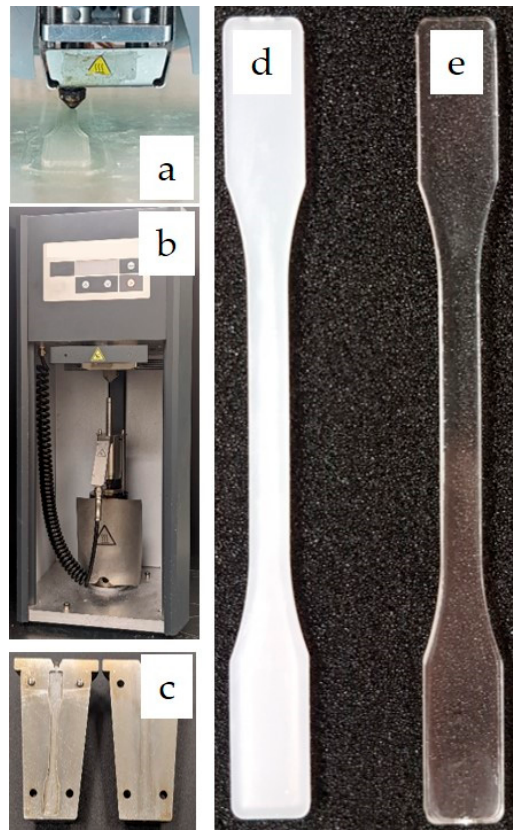
Figure 2. Image of ( a ) the FDM process, ( b ) the injection molding equipment, ( c ) mold geometry, ( d ) sample dogbone (PMMA100) made via FDM, and ( e ) sample dogbone (PMMA100) made via injec- tion molding.